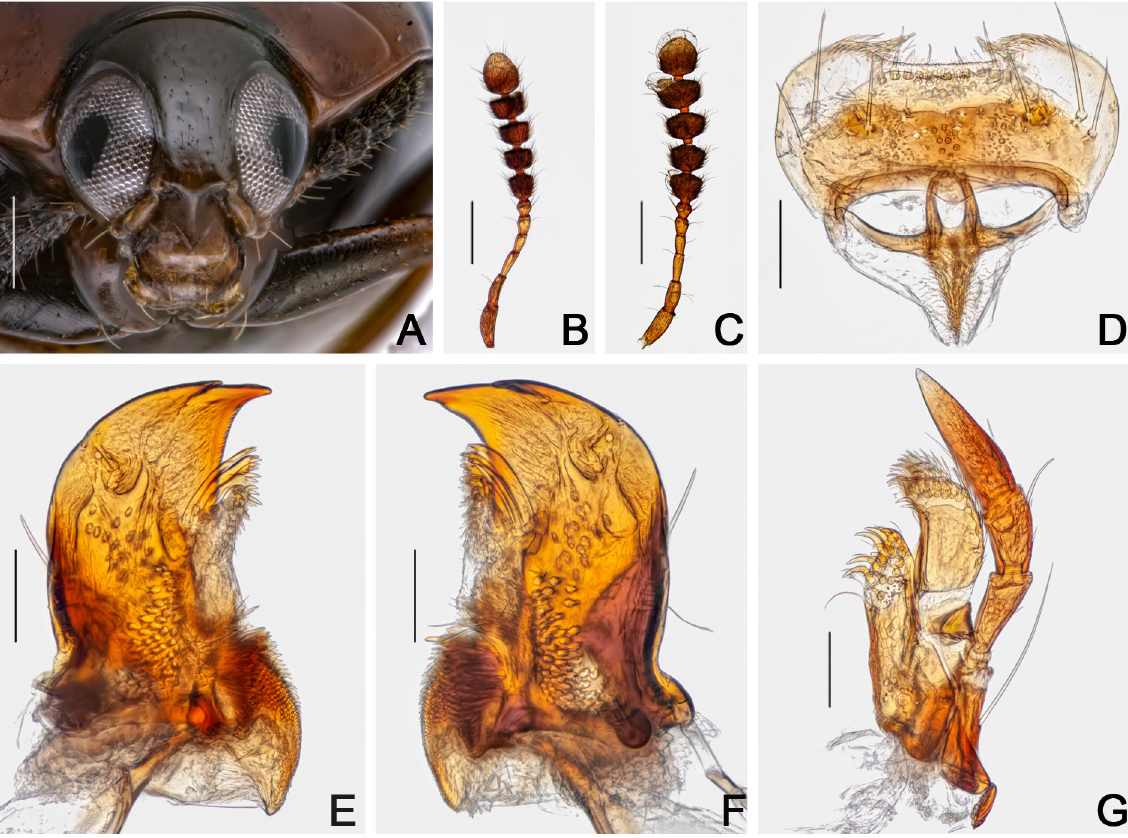
Fig. 31. Cyparium newtoni sp. nov. A . Holotype, ♂ (CELC), frontal view. B–G . Paratypes. B . Male antenna. C . Female antenna. D . Labrum. E . Left mandible. F . Right mandible. G . Maxilla. Specimens collected at Mata do Paraíso (A) and Mata da Biologia (B–G), Viçosa (MG, Brazil). Scale bars: A–C =1.0 mm; D–F = 0.2 mm; G–J = 0.05